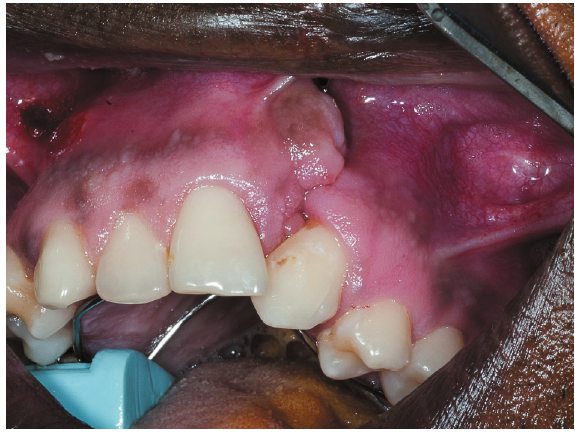
Figure 2- Preoperative view of the alveolar cleft showing the adequate keratinized